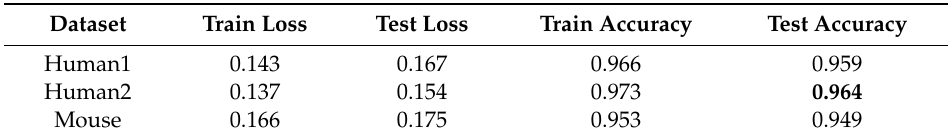
Table 2. Detailed results of our model on each dataset, including cross-entropy loss and accuracy on training and test